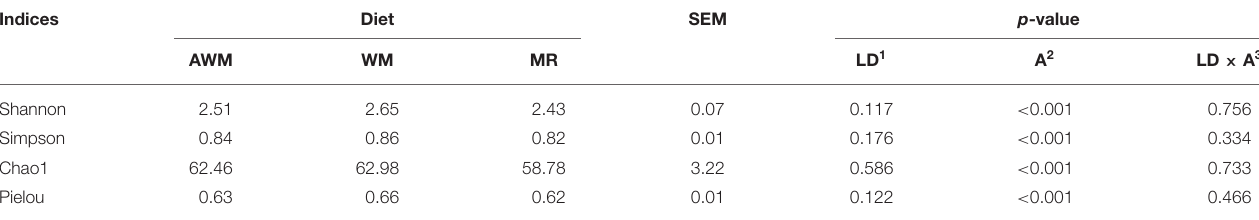
TABLE 5 | Fecal microbial diversity of calves fed with different liquid diets. Indices Diet